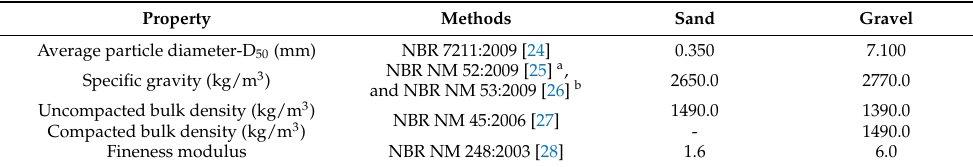
Table 2. Material properties of concrete.